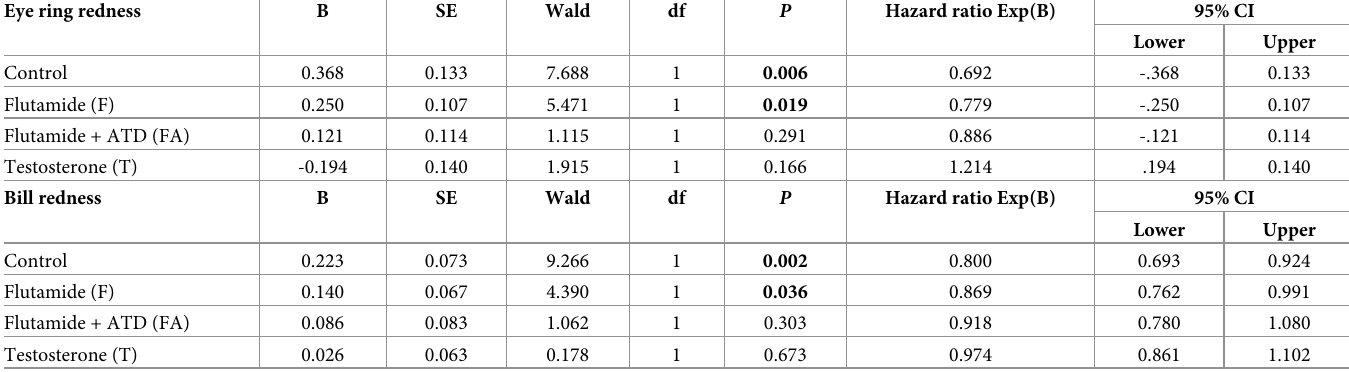
are ordered from steeper to flatter in the following way: C, F, FA and T (see Table 1). Finally, when Cox regressions were calculated separately for each treatment, the slope was significantly different from zero in C- and F-males, but not in FA- and T-treated males (Table 2), and the slopes were ordered in the same way. Additionally, Fig 1 shows raw data and ordinary least squares linear regression slopes for illustrative purposes. The non-parametric Cox regression statistics were used to avoid the lack of normality and take into account censored data. The figure shows similar trends described by Cox regression statistics. Finally, survival plots dividing the sample by redness tertiles are also reported in the supplementary material (S2 and S3 Figs). Table 2. Cox proportional-hazards regression for survival and ornament (above eye ring, below bill) redness analyzed separately for each treatment. Control (C), flu- tamide (F), flutamide plus ATD (FA) and testosterone (T). Eye ring redness B